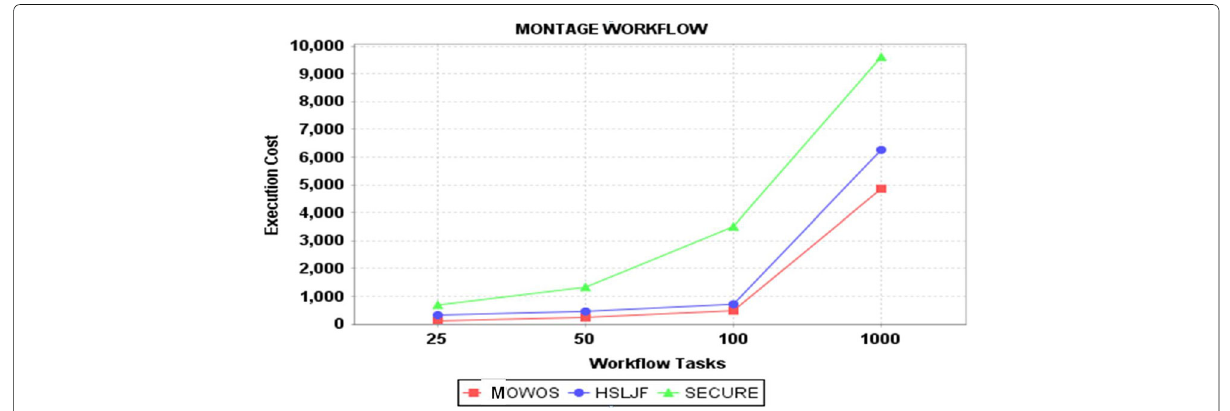
Fig. 5 Comparison of execution cost using Montage workflow